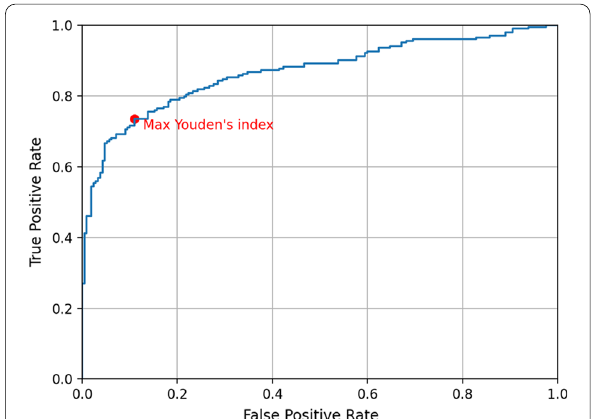
Fig. 2 The relationship between the threshold and the ratio of predictions with a confidence value larger than the threshold on the 414 samples with breast cancers